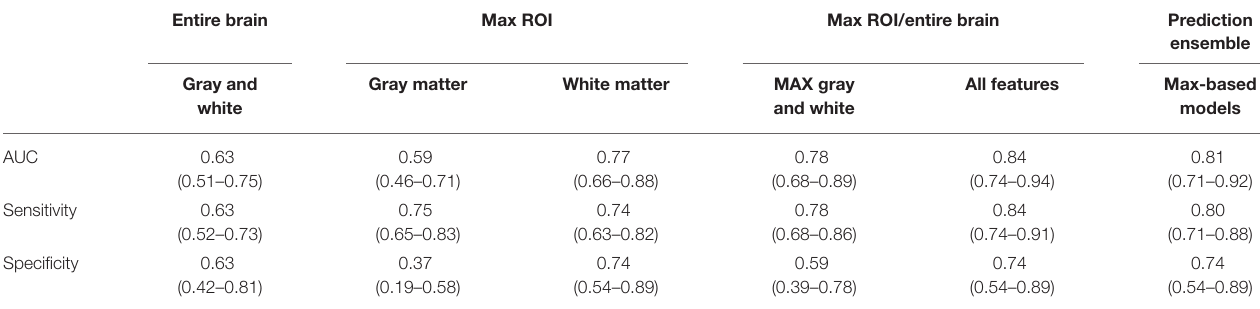
TABLE 5 | Performance of analyzed PCS models.